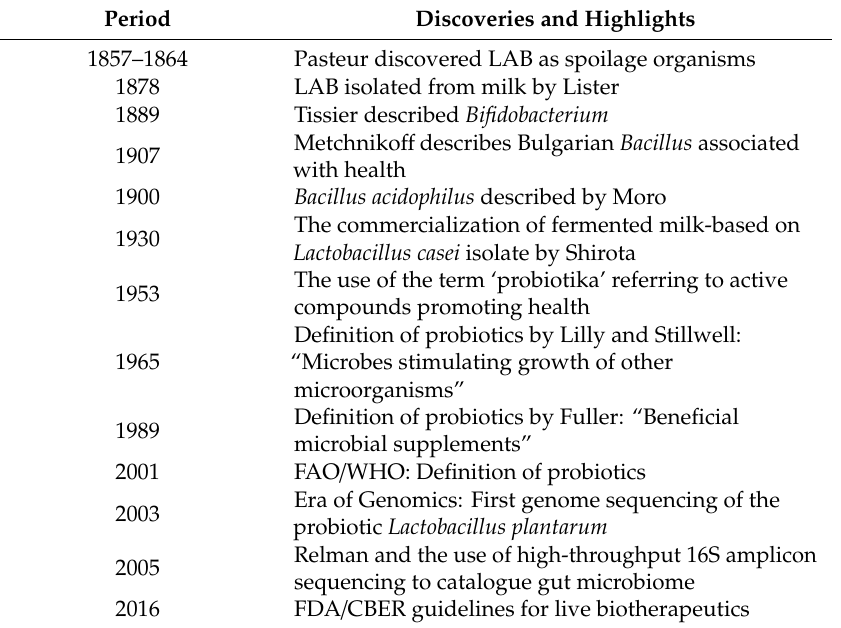
Table 1. History of probiotics—discoveries and